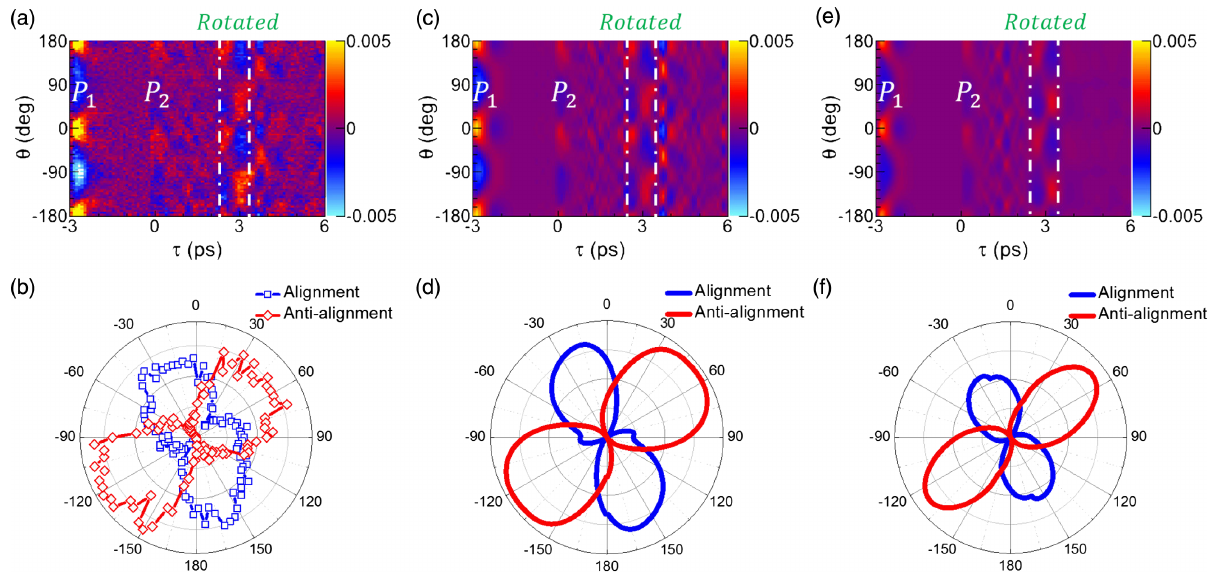
FIG. 6. Experimentally measured and theoretically simulated time-dependent angular distributions of the rotated echo in CO 2 . P 1 and P − 3 ps and 0 ps, respectively, with a crossing angle of β ¼ − 20 °. (a) Angular distribution of the rotated echo as a function of 2 arrive at the probe time delay (see the region of 2.2 – 3.5 ps between the white dashed lines). (b) Polar plots of the rotated echo at 3 ps. Panels (c) and (d) show quantum simulations, and panels (e) and (f) show classical